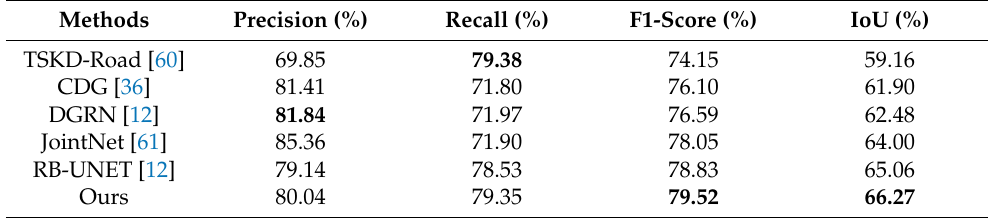
Table 2. The performance comparison of latest related methods on the Massachusetts test dataset.